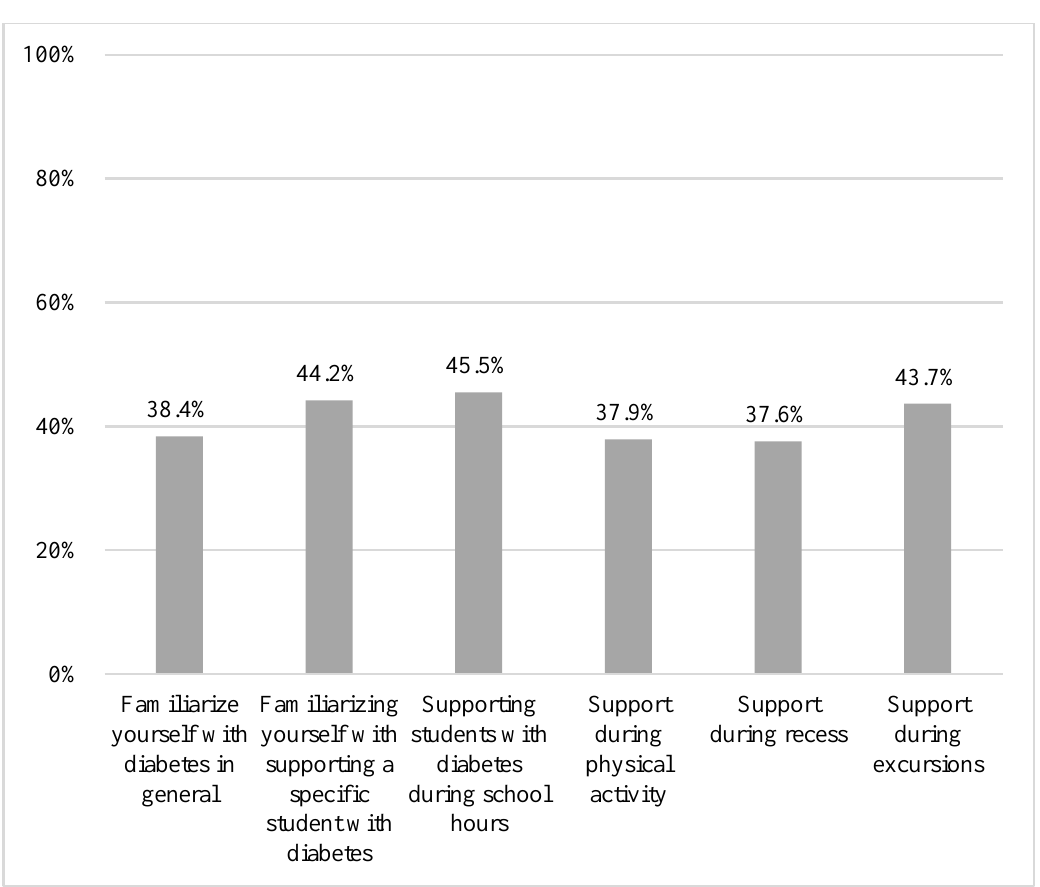
Figure 4. Proportion of participants with adequate knowledge on multiple subjects .